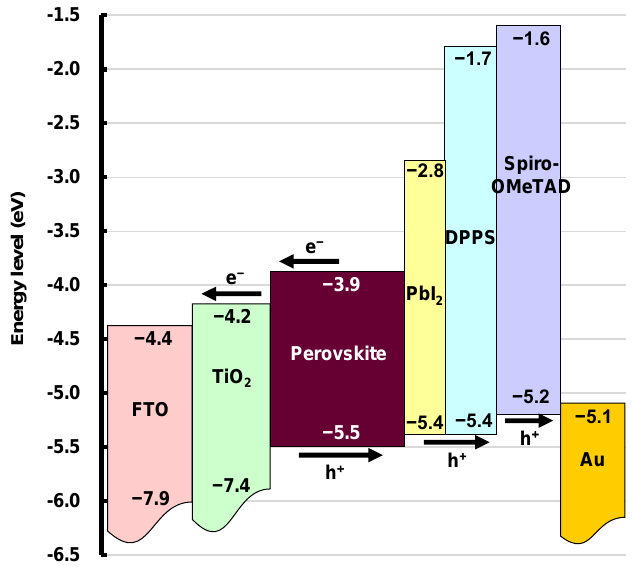
Figure 9. Energy level diagram of the present cell.